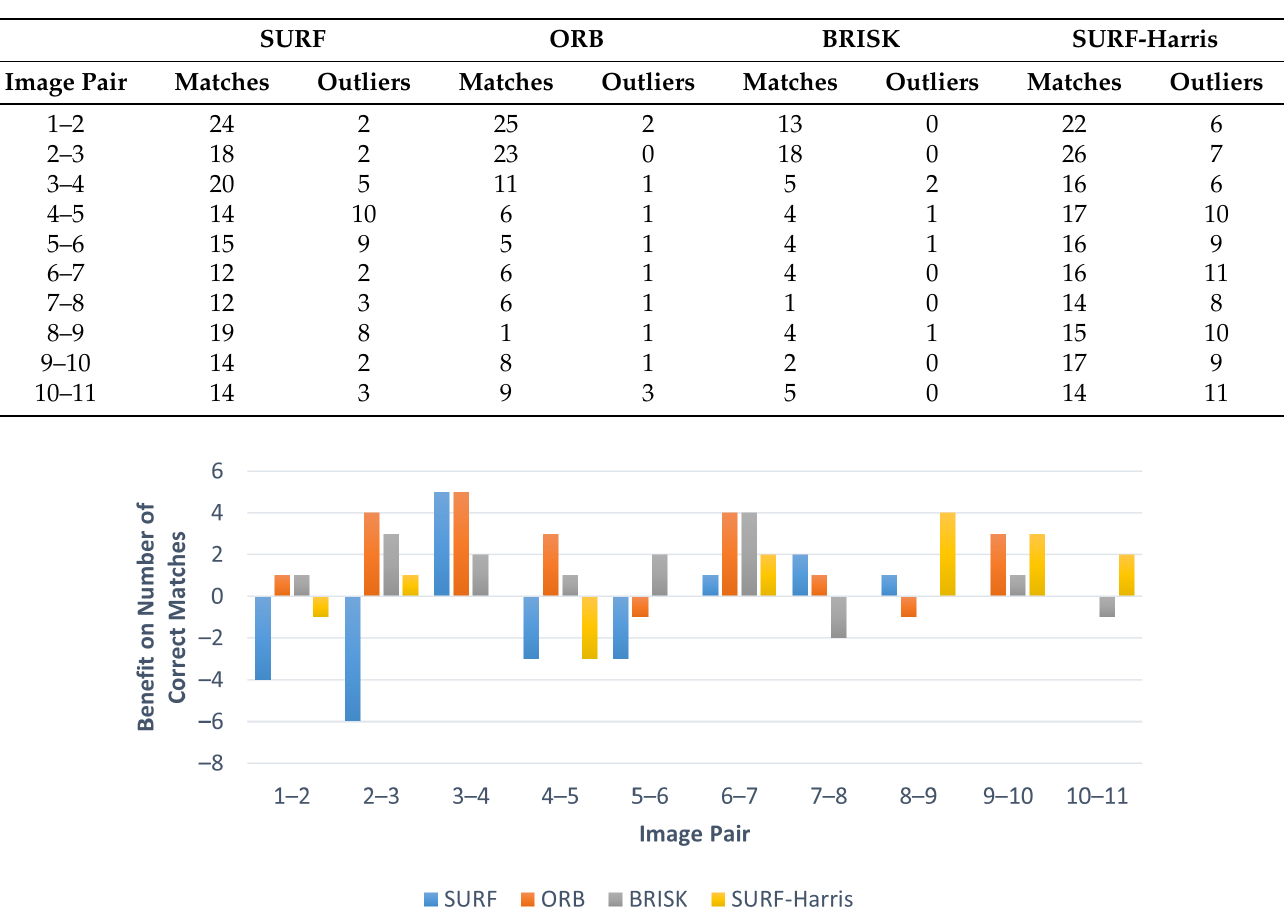
Table 8. Number of matches performed and corresponding number of outliers for dataset 2 employing the selection module.